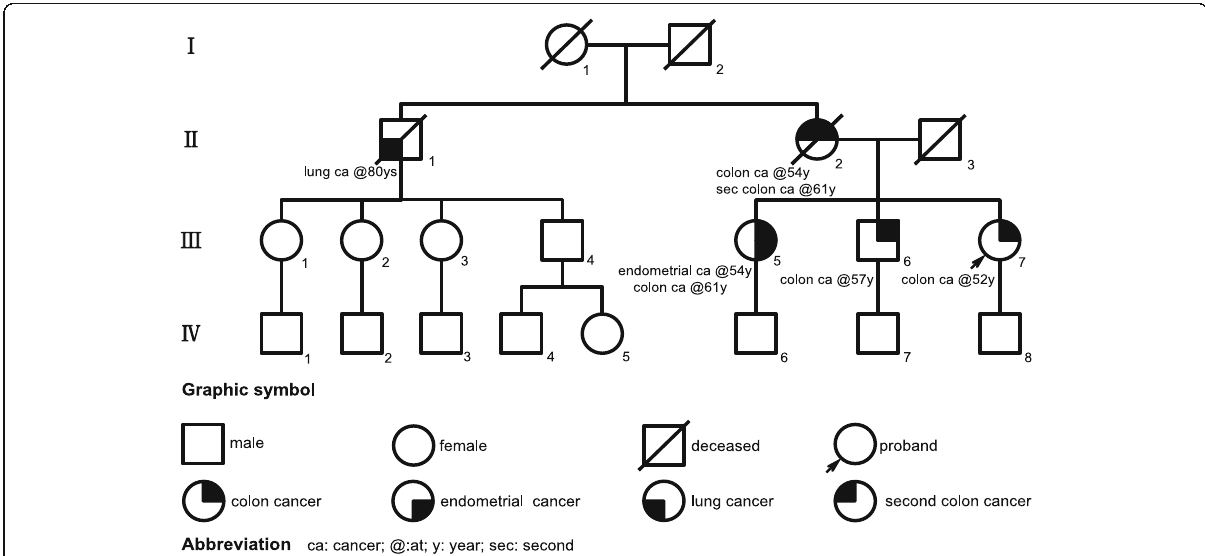
Fig. 1 Pedigree. Affected individuals III5, III6 and III7(proband) all had colon cancer and all carry the same MLH1 mutation (Table 1). With the history of colon cancer, II2 is predicted to the carrier of MLH1 mutation in the family. Among offspring of the affected individuals, IV8 carries the same MLH1 mutation (Table 1) and underwent preventative